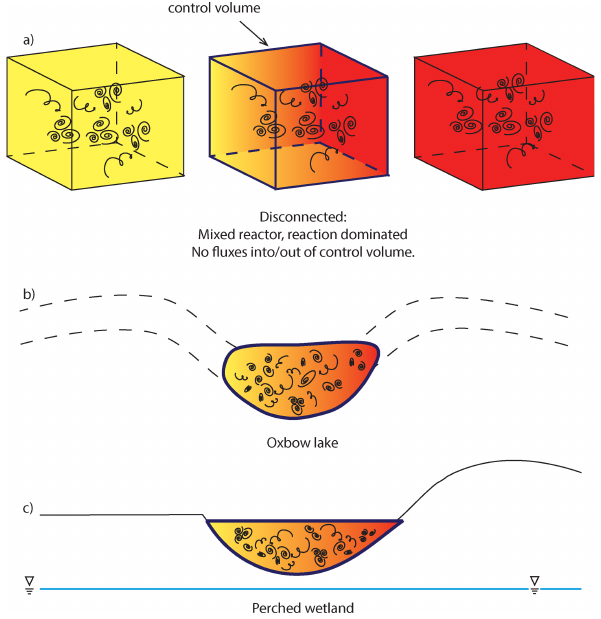
Fig. 4. Regime III: (a) the elements of interest are hydrologically and hydraulically disconnected. Examples of this regime are an oxbow lake, which has disconnected from its river (b) , and a wet- land perched above the groundwater table (c)